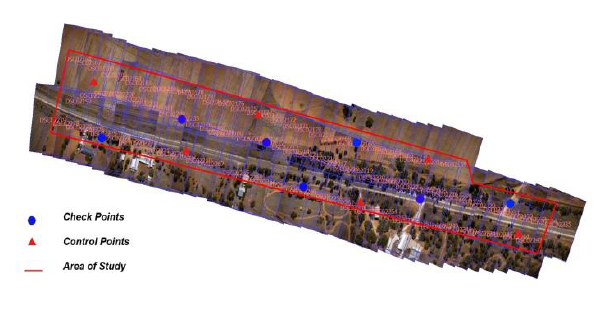
Figure 5. Test flight area with 1.6km length and 250m width. Non-signalized GCPs are acquired by RTK GPS equipment with 2cm horizontal and 4cm vertical accuracy.